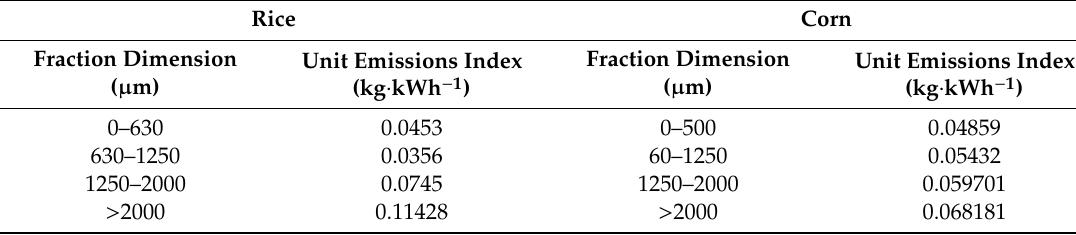
Table 5. Unit index J ACO